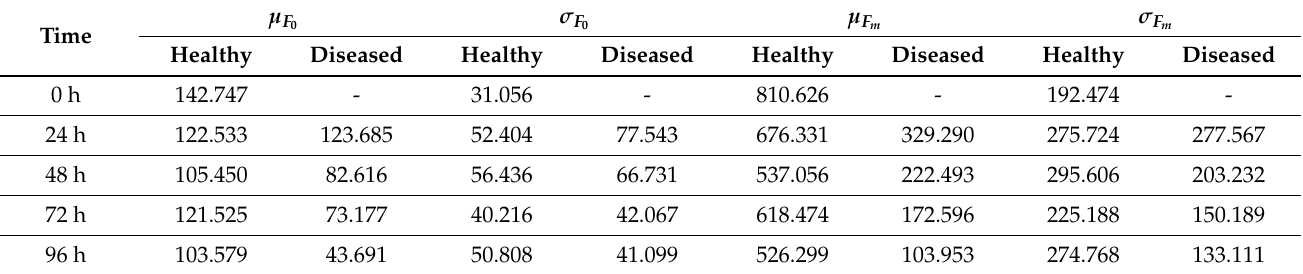
Table 3. Mean µ , and standard deviation, σ , values on Healthy and Diseased tissues of chlorophyll fluorescence parameters F 0 (minimum fluorescence) and F m (maximum fluorescence) for the data set of plants infected with fungal pathogen data. 0 h, ..., 96 h are the five times of the acquisition of chlorophyll fluorescence